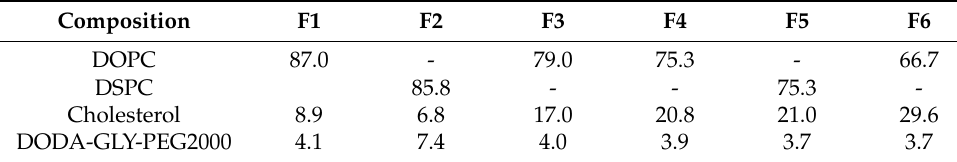
Table 1. Lipid formulations of the liposomes assayed (molar